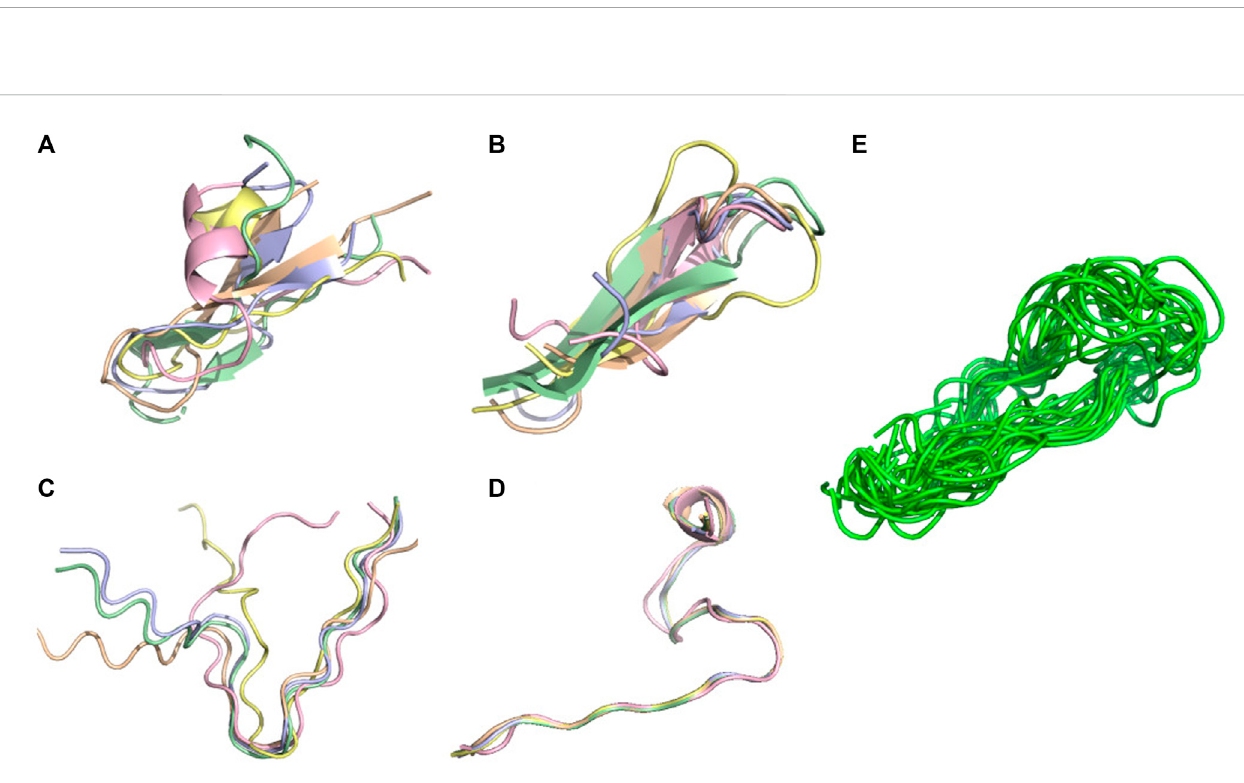
FIGURE 6 Conformational ensemble of 7li2. (A) PF-noDH, (B) PF-DH at pH 4.3, (C) AlphaFold2, (D) TrRosetta, (E) NMR structure. For A, B, C and D the 5 predicted models are depicted. For E, all models provided in the PDB are